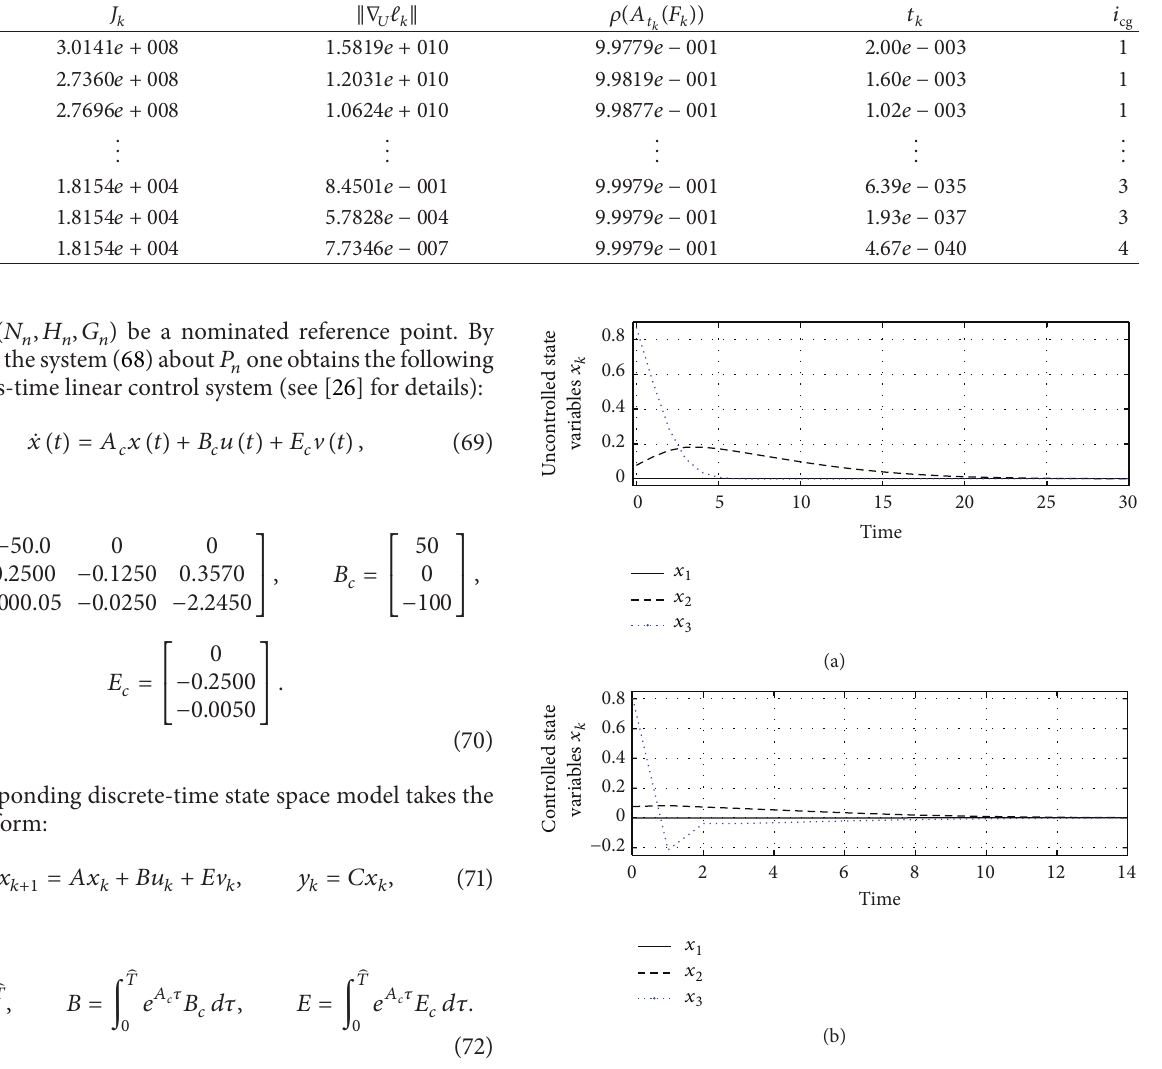
Table 4: Convergence behavior of the method DSQP for Example 19.